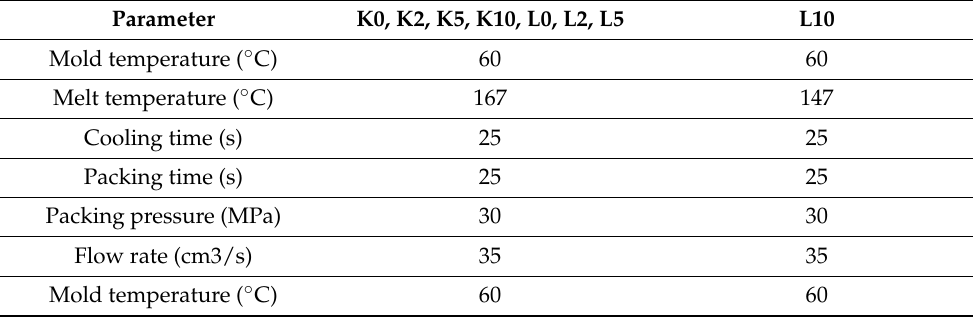
Table 2. The processing parameters of samples for uniaxial tensile